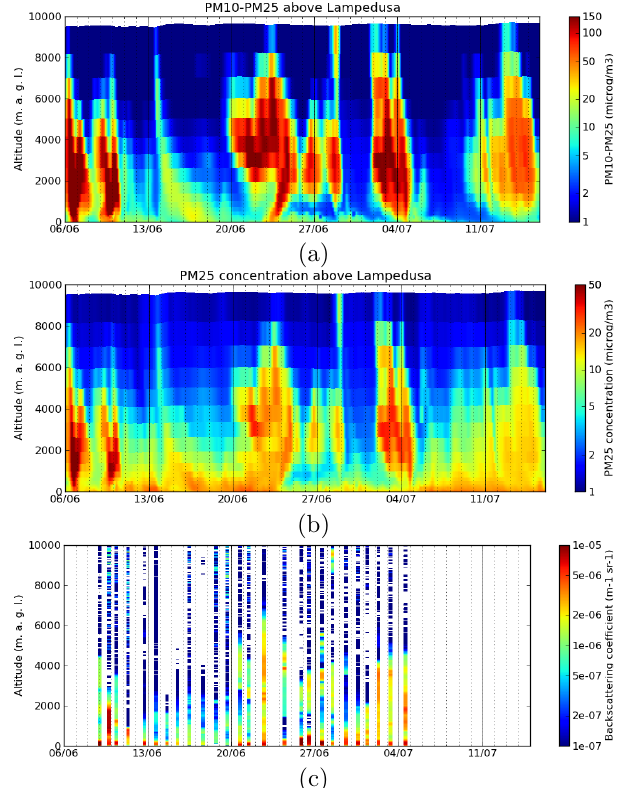
Figure 9. (a) Evolution of modelled coarse particles concentrations (PM 10 –PM 2 . 5 ) above Lampedusa; (b) same as (a) but for the fine particles (PM 2 . 5 ); (c) LIDAR backscatter coefficient above Lampe- dusa. Each selected LIDAR profile is represented by a column of fixed width centred on the instant of the measurement, representing the backscatter coefficient (colour levels).